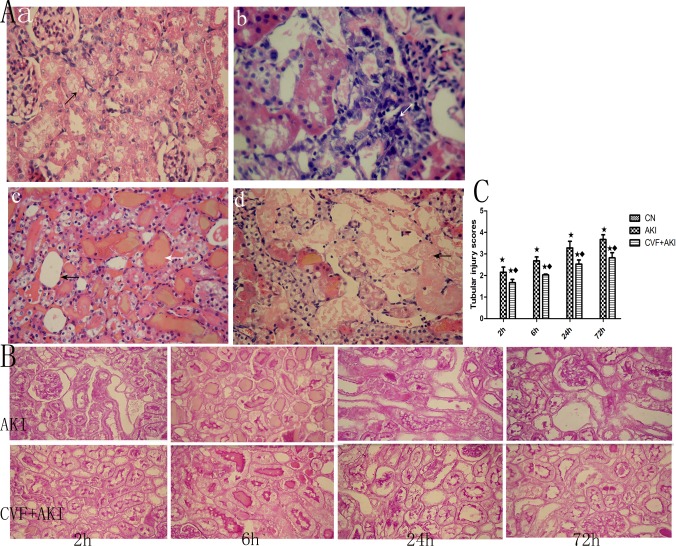
Evaluation of renal histopathology changes.(A) Renal injury in the AKI group was aggravated over time. a. AKI at 2 h, renal tubular epithelial cell degeneration (H&E, ×200); b. AKI at 6 h, inflammatory cell infiltration (H&E, ×400); c. AKI at 24 h, the black arrow indicates the bare basement membrane, and the white arrow indicates the myoglobin tube type (H&E, ×200); d. AKI at 72 h, large patchy necrosis, normal structures disappear (H&E, ×200). (B) The pathological renal changes in the AKI+CVF group were more moderate than those in the AKI group (PAS, ×200). (C) Tubular injury scores of each group. The score of the control group was zero. ★ P<0.01 vs. control; ◆ P<0.01 vs. AKI.